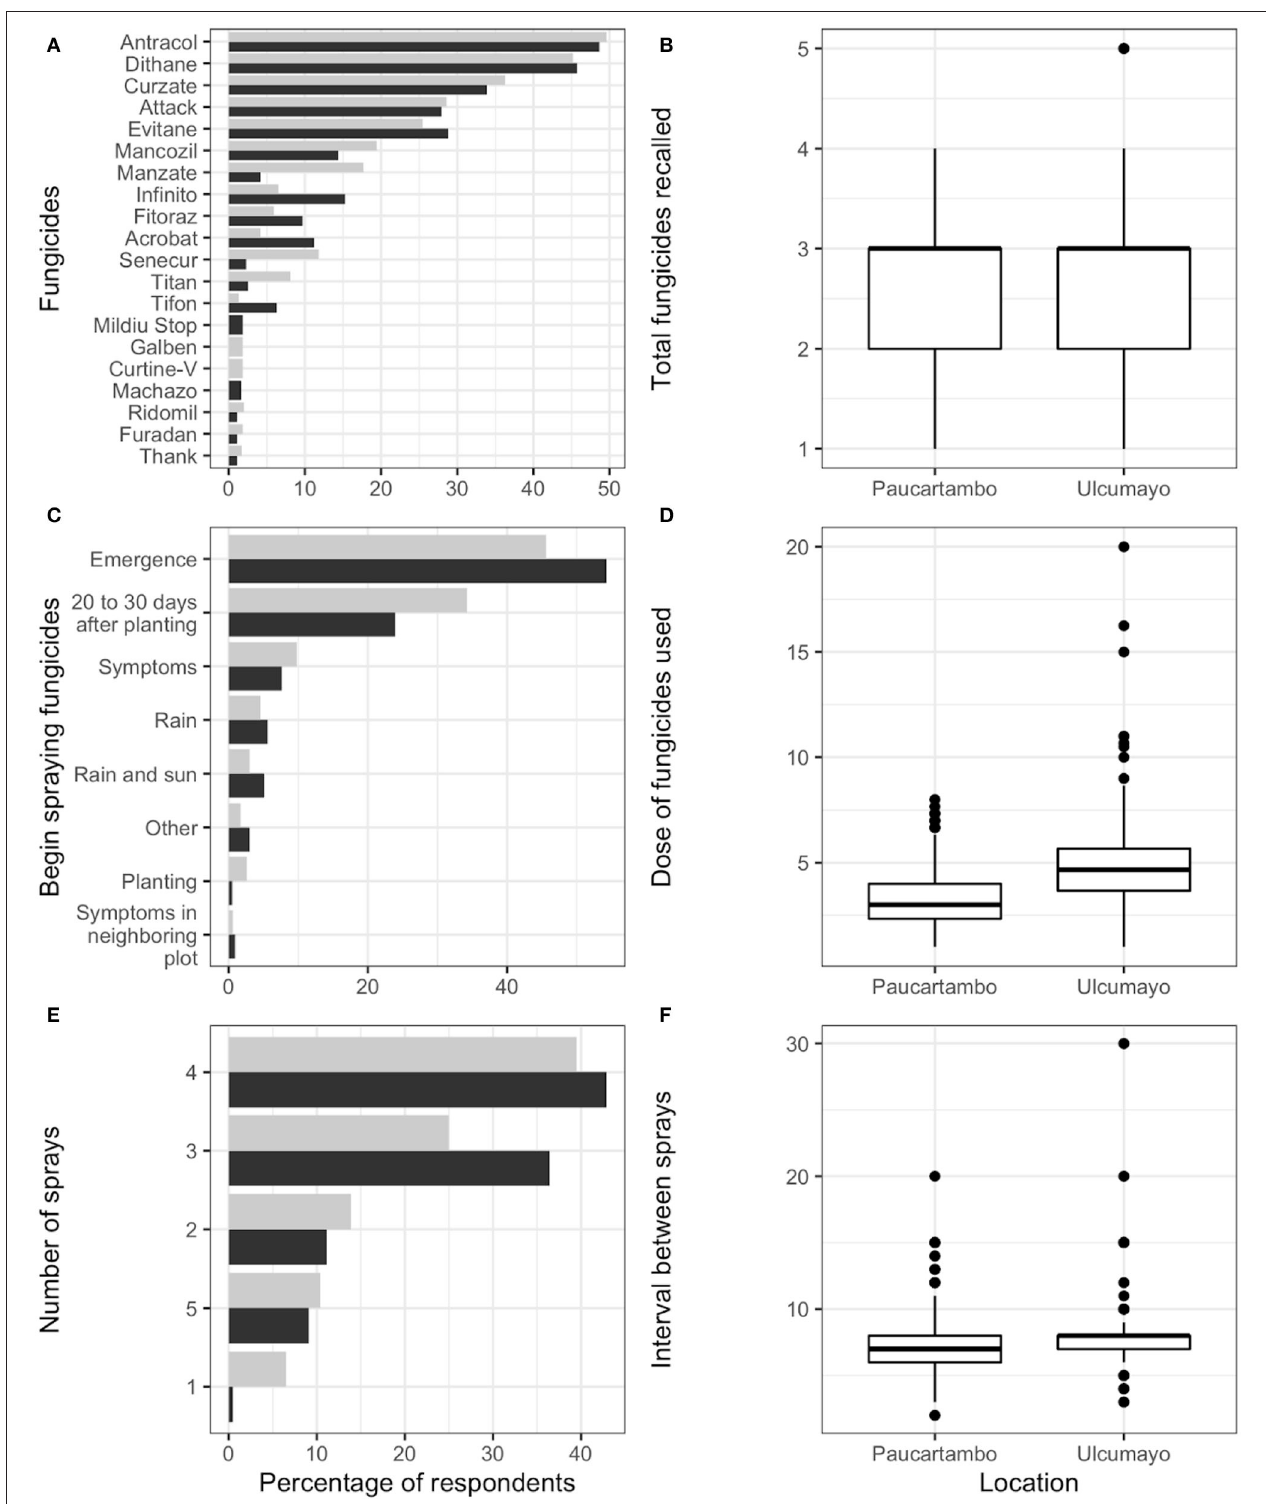
FIGURE 5 | Percentage of respondents choosing most widely used fungicides, of which those with at least 1% of respondents are shown here (A) , total number of fungicides (B) , reason for initiating the first late blight spray (C) , dose of fungicides per 20l sprayer (D) scaled number of sprays [(1, fewer than 5 sprays; 2, between 6 and 10 sprays; 3, between 11 and 15 sprays; 4, between 16 and 20 sprays; 5, more than 20 sprays)] (E) , and interval between sprays (F) in Paucartambo, black bars; Ulcumayo, gray bars. Chi-square tests (A,C,E) for independence of factors were significant, as were the Wilcoxon rank sum tests for differences in means (B,D,F) .